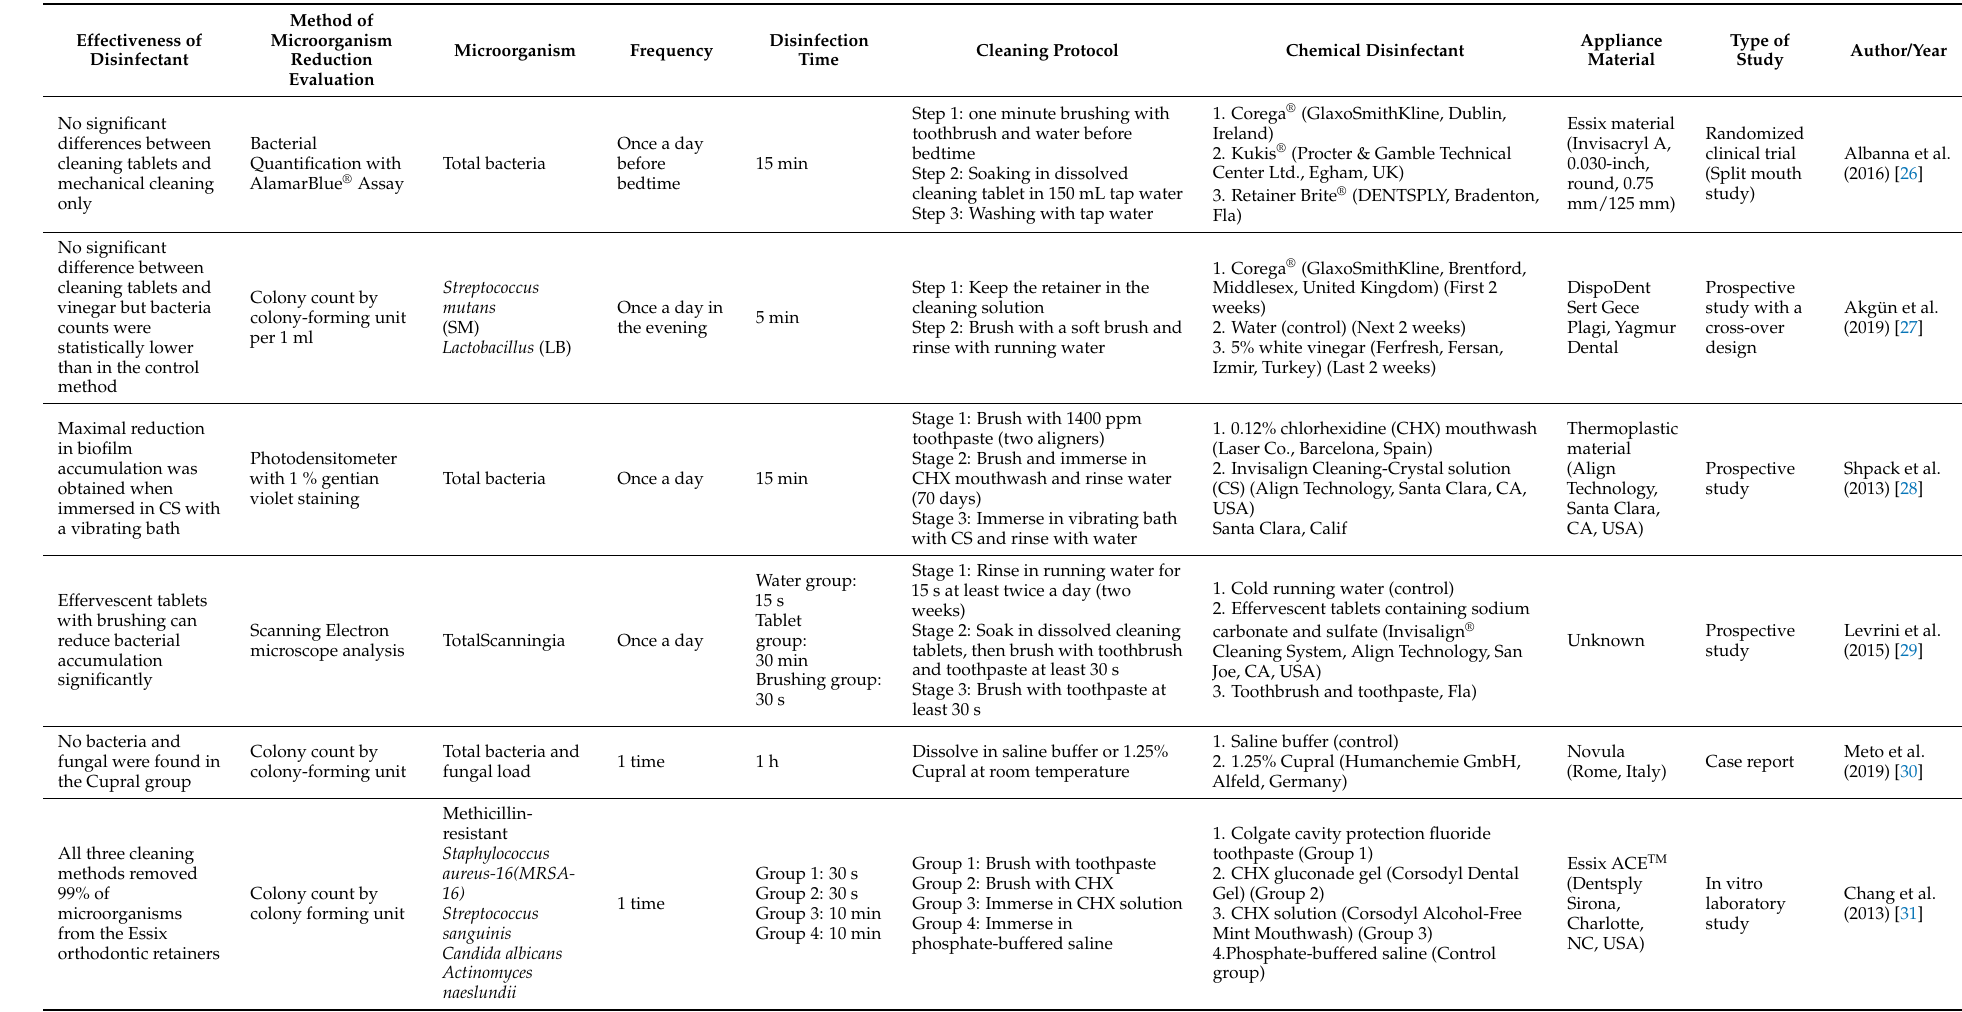
Table 3. Overview of included